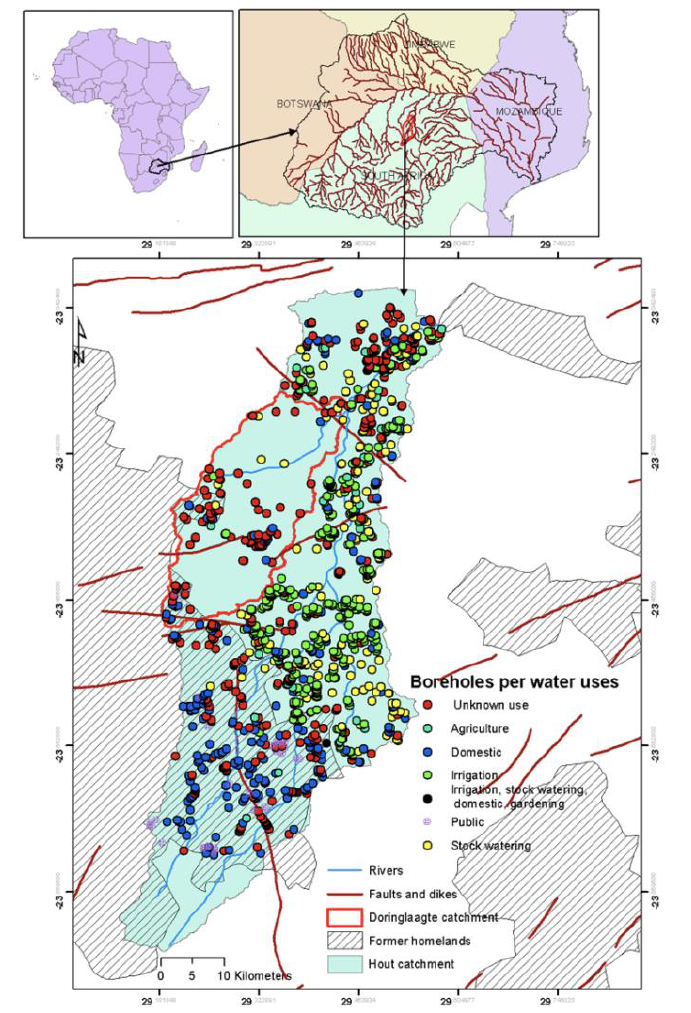
Fig. A1.1. The study area’s location within the Limpopo basin. The area lined in red denotes the Doringlaagte, where the majority of the case study research was carried out (source: Fallon et al.